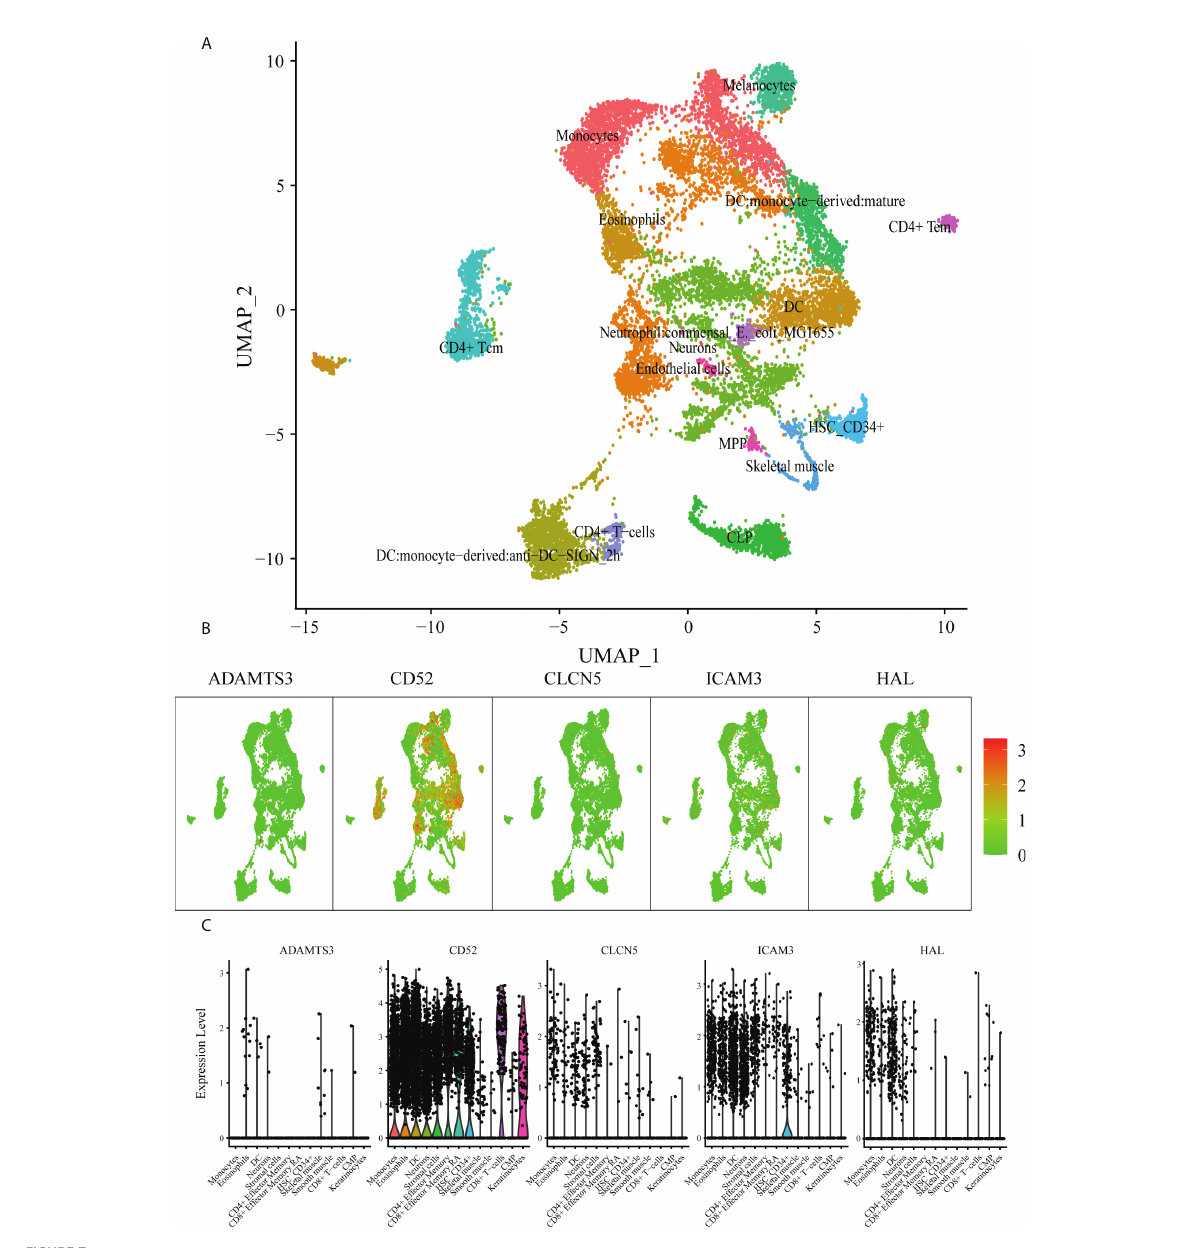
FIGURE 7 scRNA analysis of hub genes. (A) Clustering analysis of the UMAP plot, color coded based on cell types. (B) Overlaying gene expression on UMAP clusters to illustrate the distribution of hub genes in each cell type. (C) Violin plots of hub genes in each cell